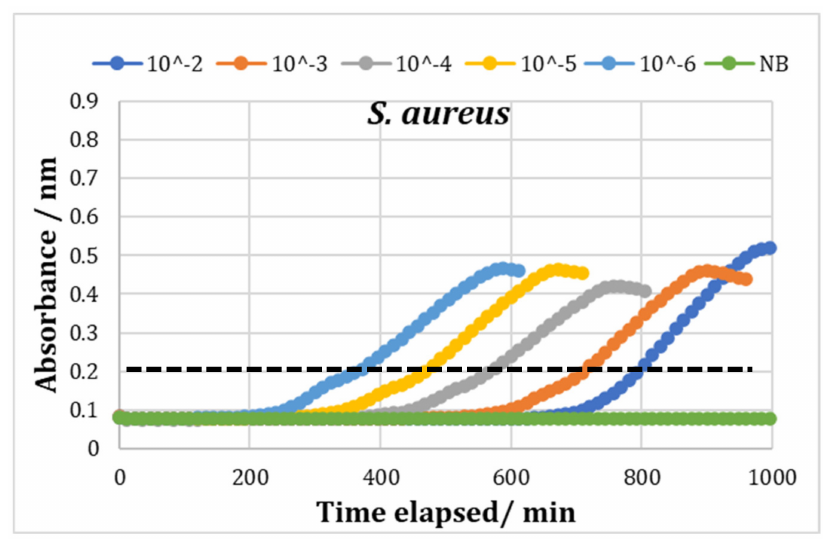
Figure 8. Growth curves of different concentrations of E. coli and S. aureus . All data points are averages of three parallel samples, with error bars representing standard deviation. The dotted black line represents the detection limit, Abs600 = 0.2.